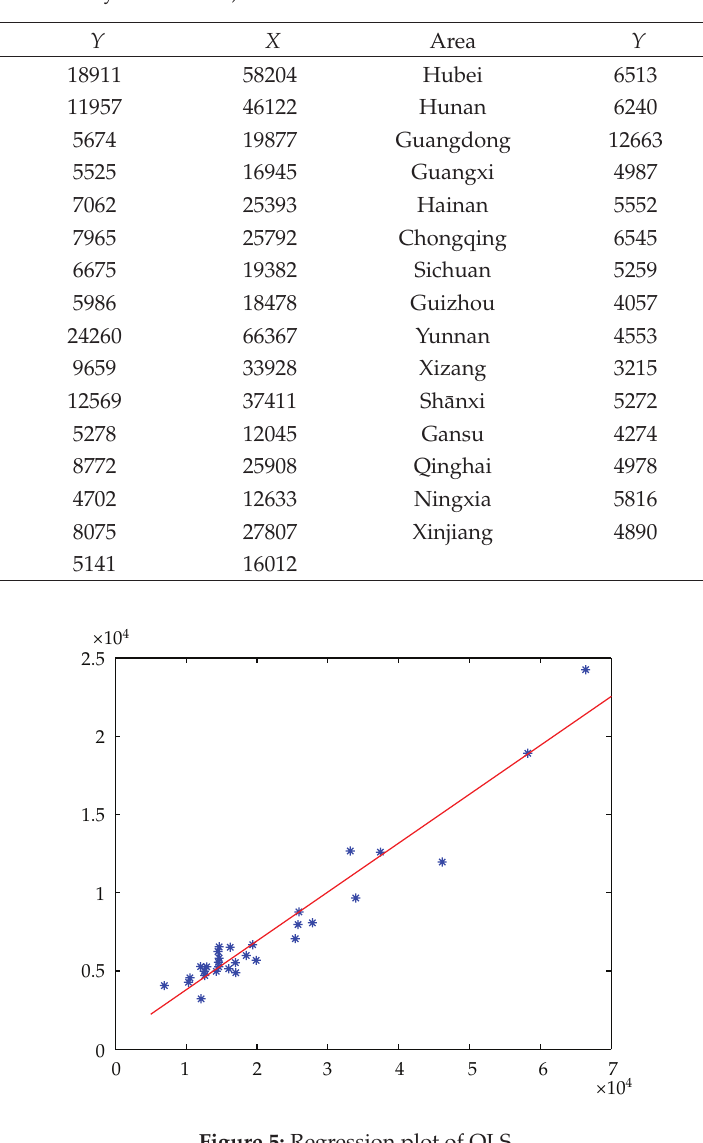
Figure 5: Regression plot of